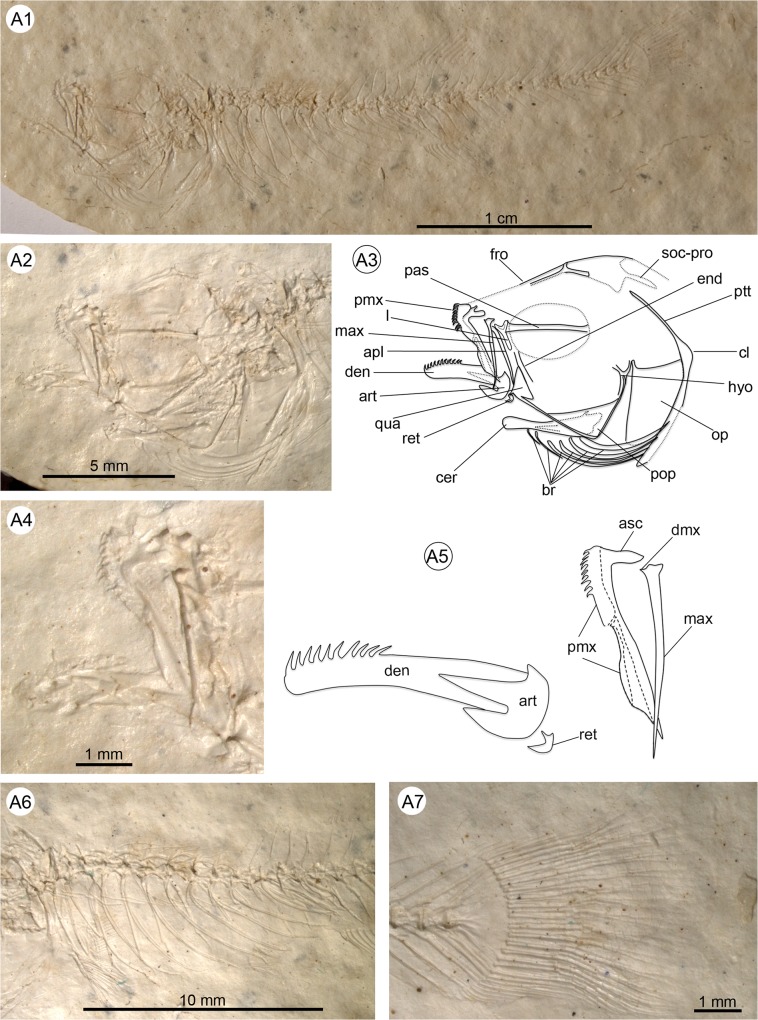
Anatomical details of †Kenyaichthys nov. gen. (holotype 1209a´05, †K. kipkechi), left lateral view.
A1 General overview (photograph by Dr. W. Altner); A2–A3 Close up of the head and pectoral girdle (the lacrimal is from the counterpart and mirrored for clarity); A4–A5 Close-up of lower and upper jaw; A6 Detail of abdominal part showing vertebrae, pleural ribs and epipleural ribs; A7 Truncate to rounded caudal fin. Abbreviations: apl, autopalatinum; art, anguloarticular; asc, premaxillary ascending process; br, branchiostegal rays; cer, ceratohyal; cl, cleithrum; den, dentary; dmx, dorsal maxillary process; end, endopterygoid; fro, frontal; hyo, hyomandibula; l, lacrimal; max, maxilla; op, operculum; pas, parasphenoid; pmx, premaxilla; pop, preoperculum; ptt, posttemporal; qua, quadratum; ret, retroarticular; soc-pro, supraoccipital process.